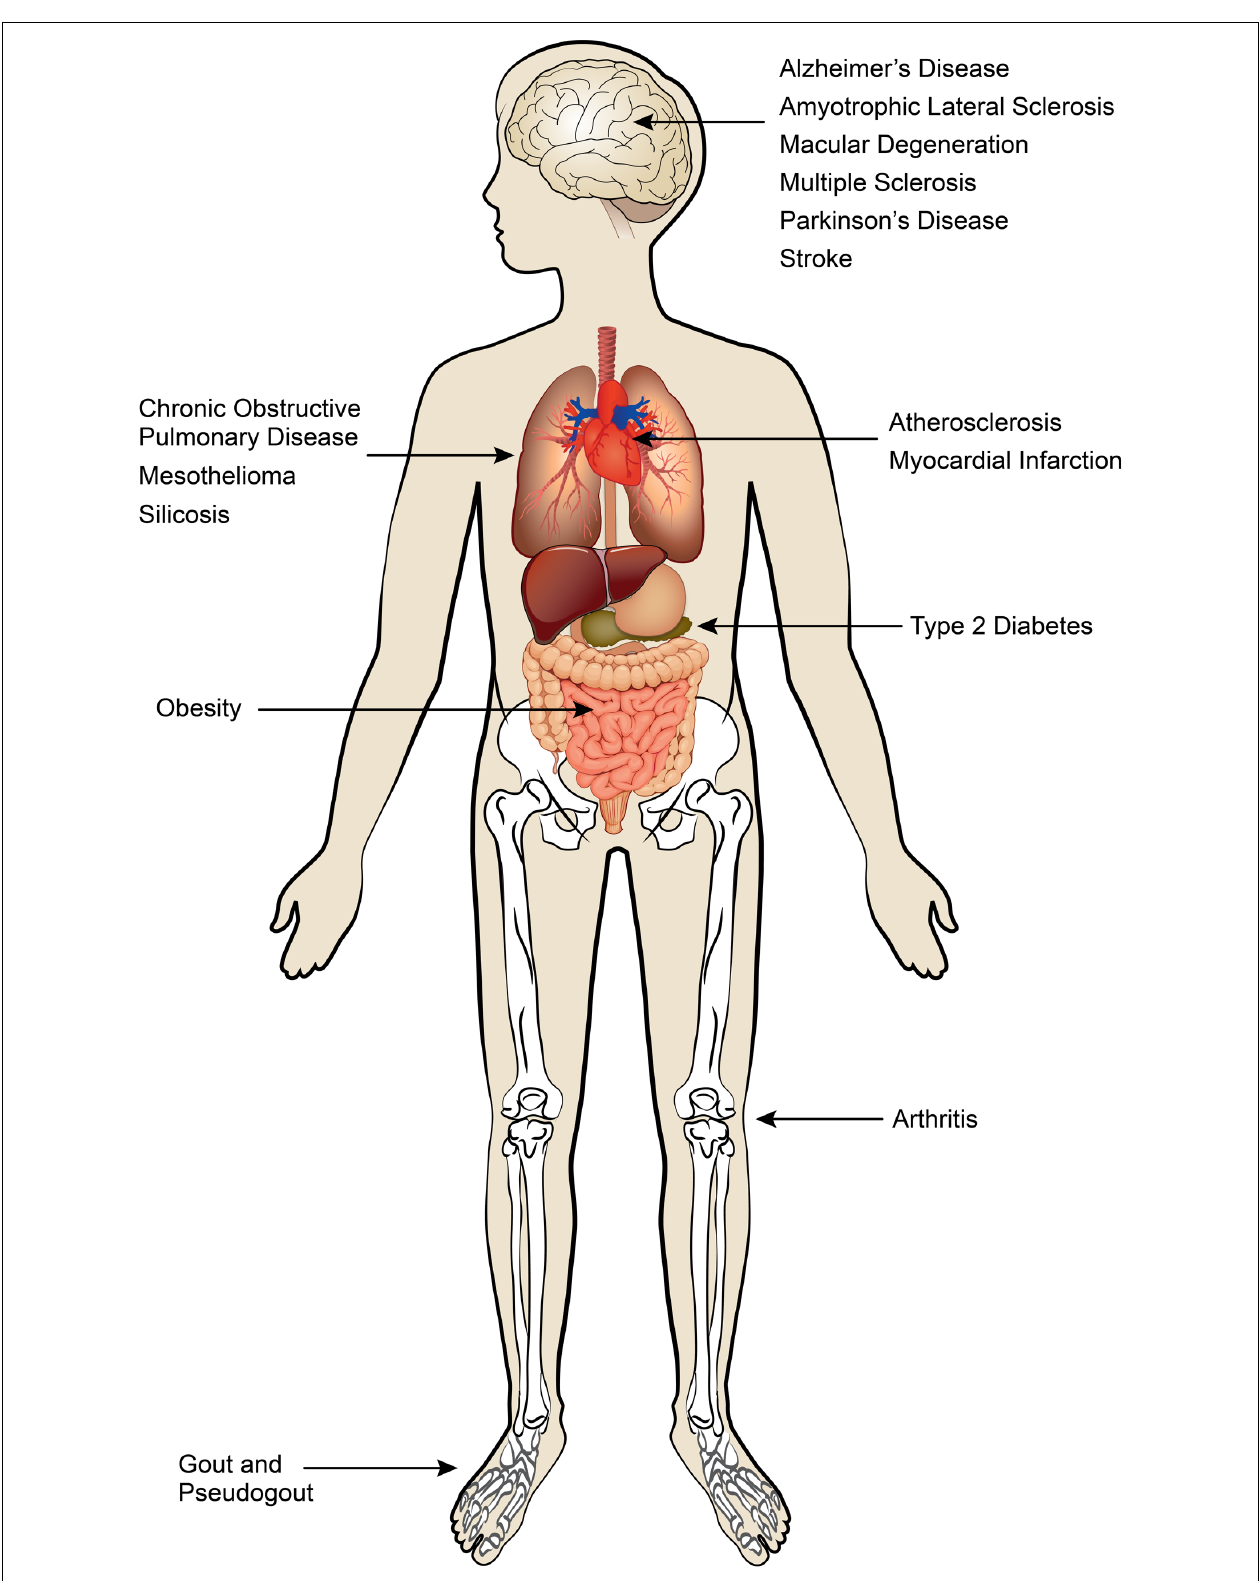
FIGURE 1 | Sterile inflammatory diseases. Sterile inflammatory diseases can affect multiple organ systems and are a major threat to global human health.